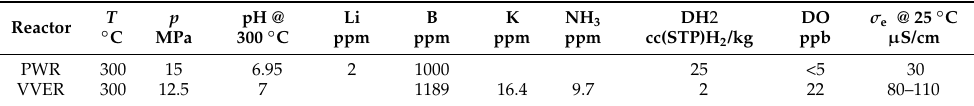
Table 3. Definition of the water chemistry; σ e is the electric conductivity; DH2 and DO are the dissolved hydrogen and oxygen